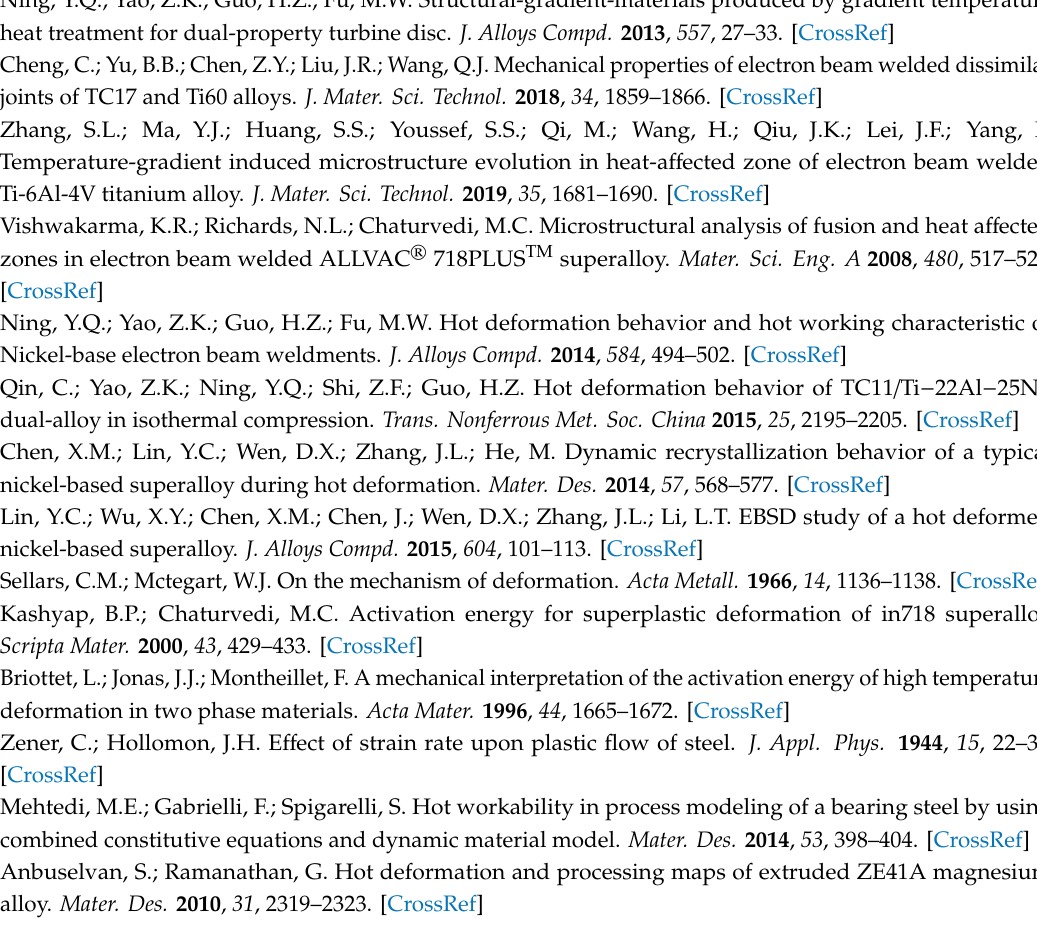
A new approach for finding the instable region from power dissipation map was proposed: the “cli ff ” and “valley” features are the su ffi cient conditions of flow instability. According to the power dissipation map and microstructural characterization, the optimum hot plastic deformation parameter is suggested to be 1140 for manufacturing the dual-property turbine